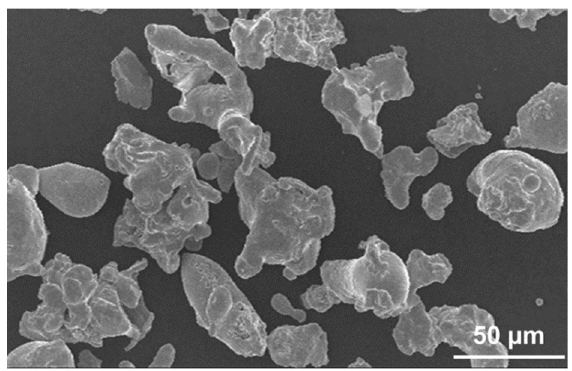
Figure 1. SEM image of irregularly shaped stainless steel 316L feedstock powder used.